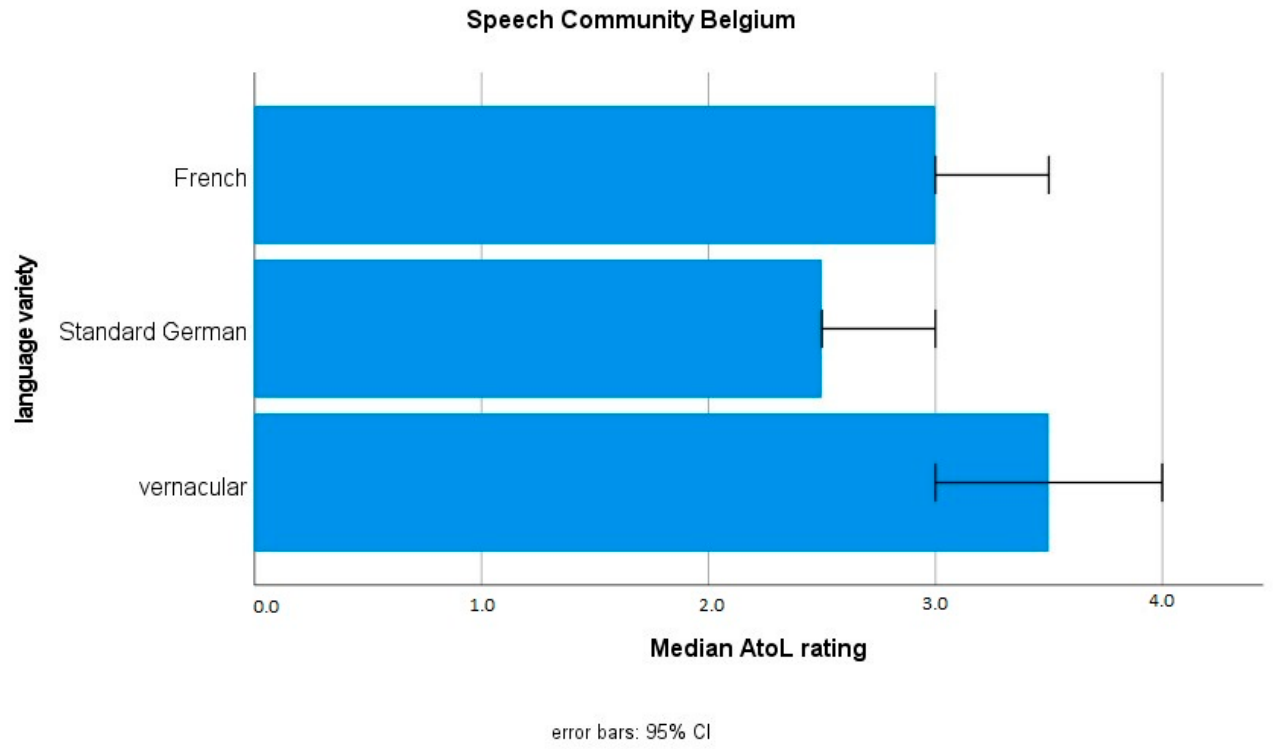
Figure 4. AtoL ratings in Belgium for: vernacular** (median = 3.50; IQR = 2.50, 3.50, 4.00), standard* (median = 2.50; IQR = 2.00, 2.50, 3.00), French** (median = 3.00; IQR = 2.50, 3.00, 4.00). * sign. different to all other varieties; ** sign. different to standard variety.